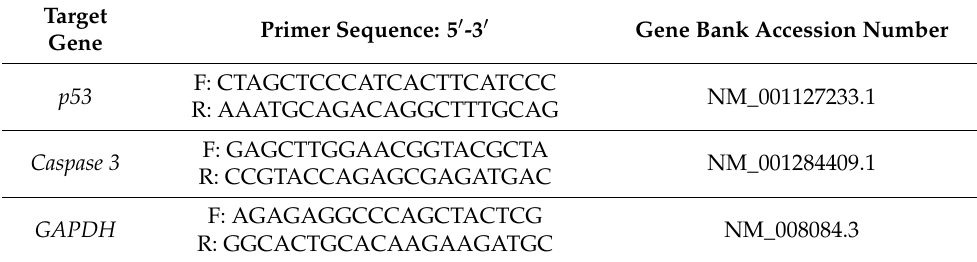
Table 2. Primer sequence and Gene Bank accession number for each